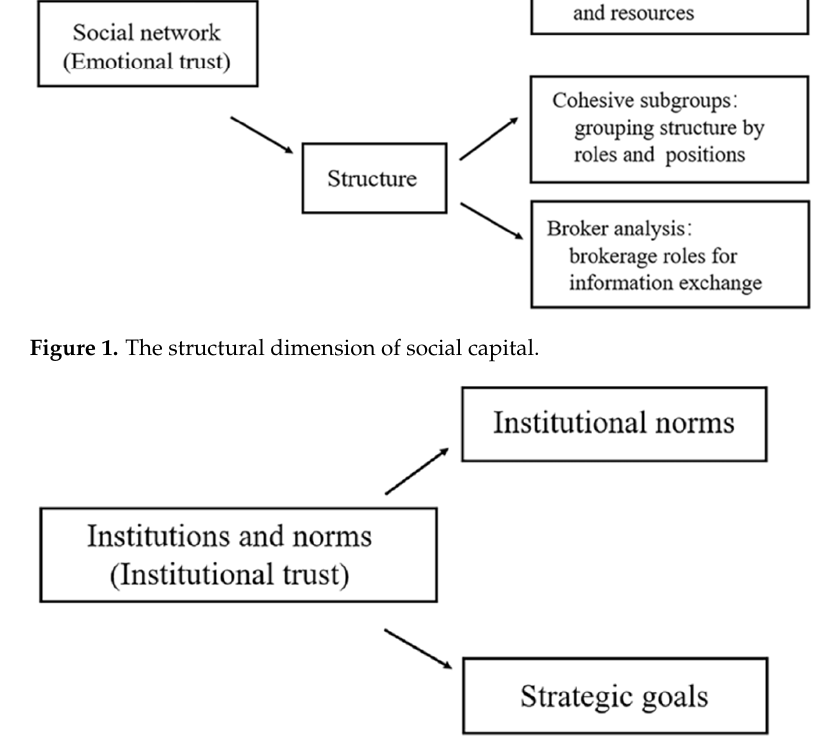
Figure 2. The cognitive dimension of social capital.